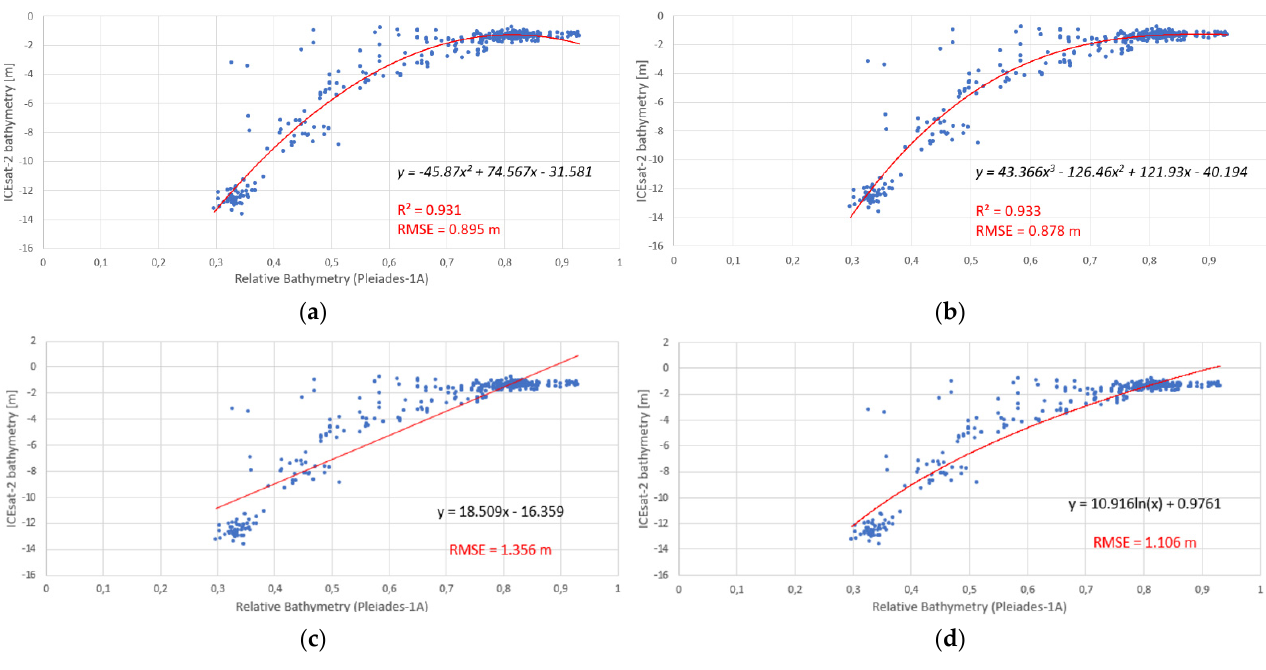
Figure A1. Different regression models tested to link the relative bathymetry points to ICESat-2 bathymetric measurements. ( a ) Second degree polynomial regression; ( b ) third degree polynomial regression; ( c ) linear regression; ( d ) logarithmic regression.